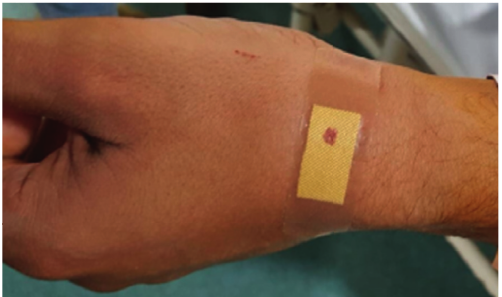
Figure 3: Posthaemostasis noncompressive tape over puncture